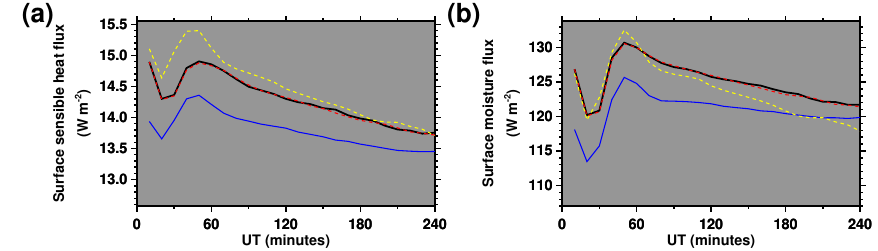
Figure 2. Time series from the spin-up runs m (black), m fine (yellow), l (red), l 1 : 5 (blue). Spin-up runs are listed in Table 1.